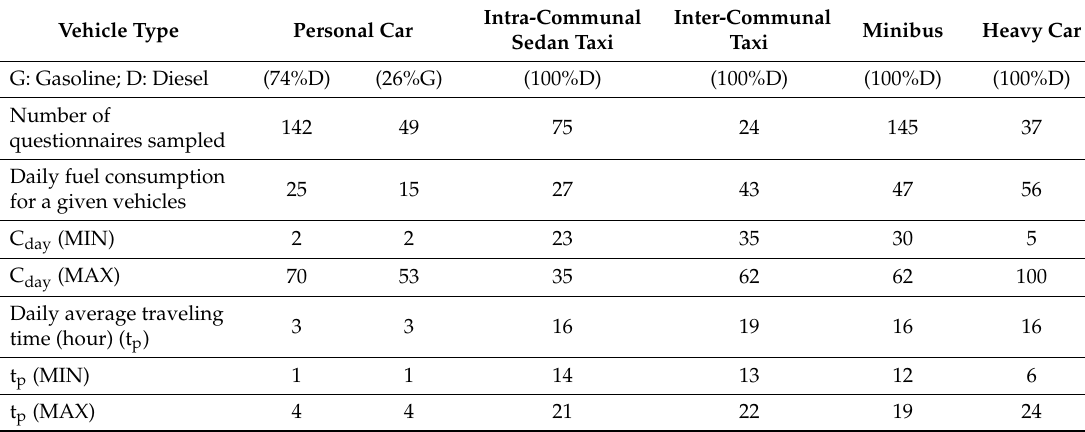
Table 4. Daily fuel consumption (C day ) and traveling time (t p ) for vehicle type, MIN and MAX represent the minimum and maximum of (C day ) and (t p )